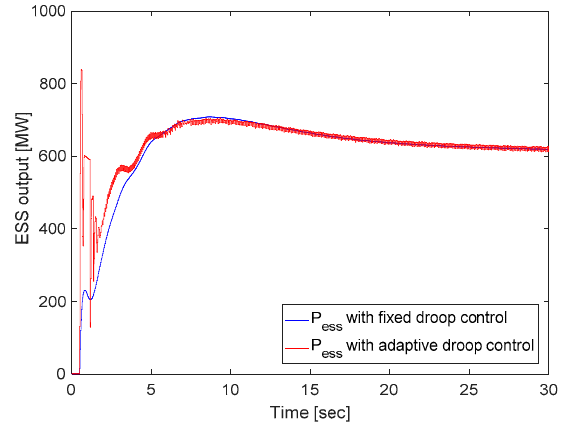
Figure 10. ESS power output depending on droop control.